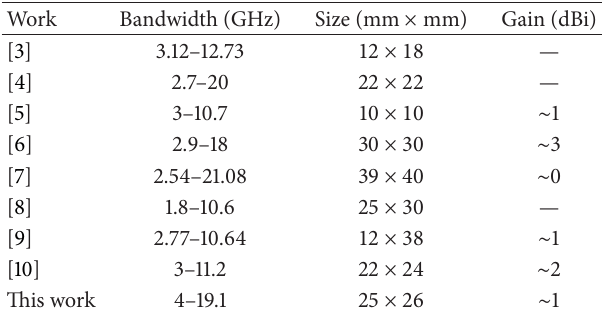
Table 1: Comparison of the proposed antenna with the recently published selected